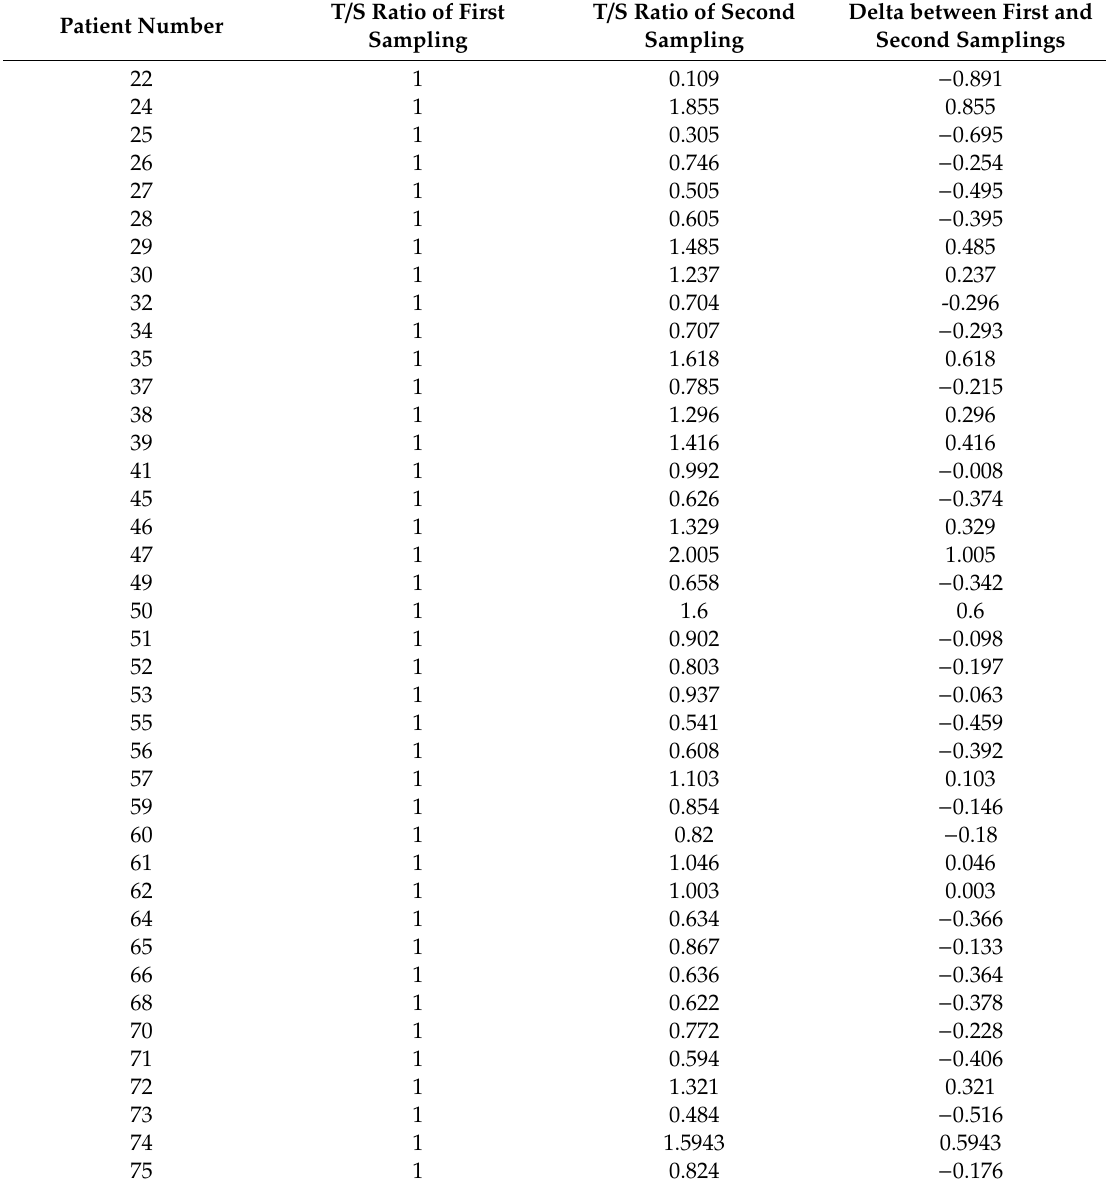
Table 2. Detailed telomer length change from first sampling to second